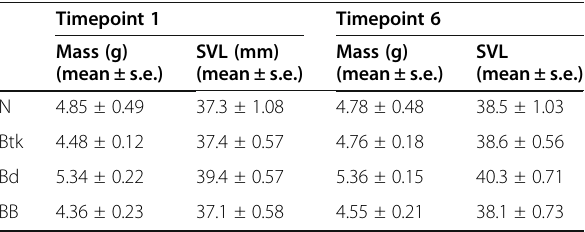
Table 5 Average mass and SVL for each experimental group at timepoint 1 and timepoint 6 Timepoint 1 Timepoint 6 Mass (g) (mean ±